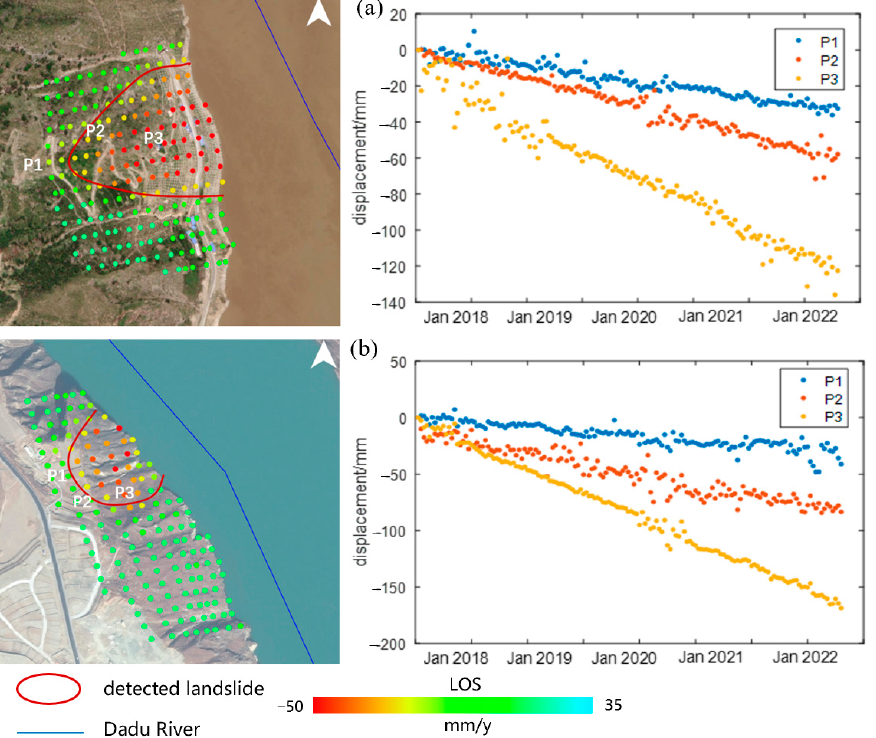
Figure 12. The time series displacement for two typical landslides detected in Danba ( a ) and Luding ( b ), respectively. ( b ), respectively. Sensors 2023 , 23 , x FOR PEER REVIEW